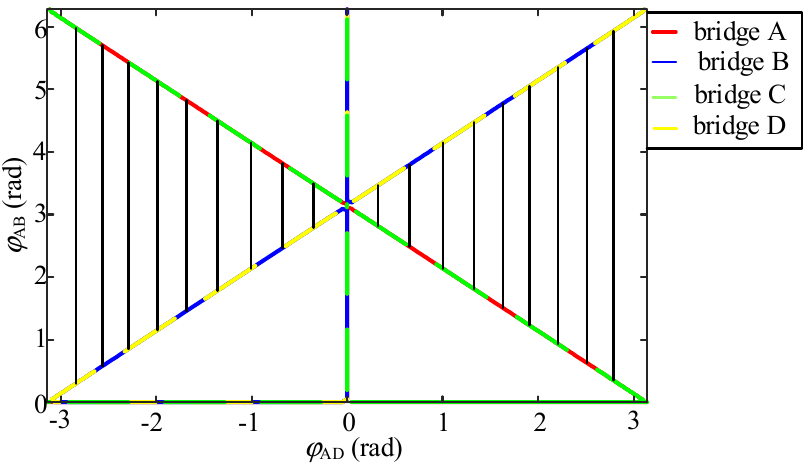
Figure 7. ZVS area under DPS modulation.